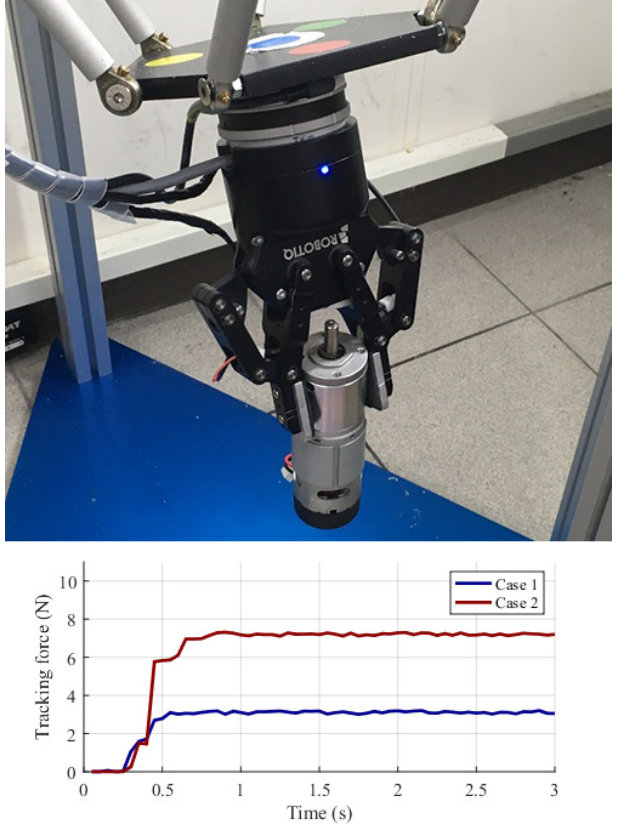
Figure 15. The tracking force of the comparative Experiment 3. Table 5. The experiments for the comparison.